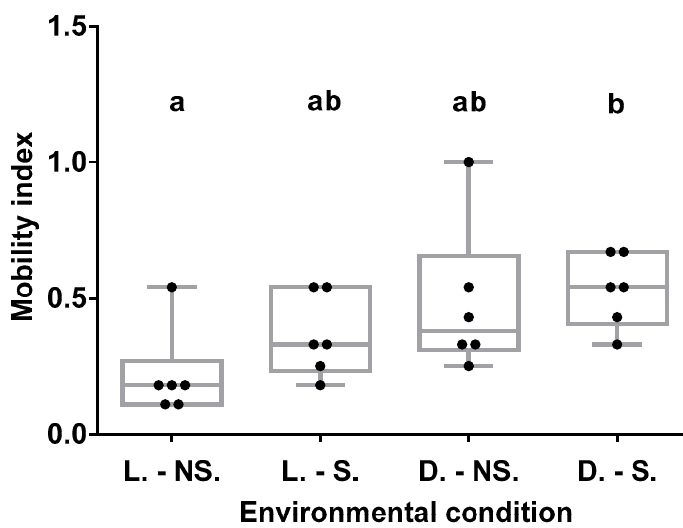
Figure 3. Darkness and starvation are the conditions that generate the most movement on C. sordidus (BW), they are the best environmental conditions for analyzing the mobility of BW in olfactometer assays. Abbreviations: L-NS = Light and no starvation, L-S = Light and starvation, D-NS = Darkness and no starvation and D-S = Darkness and starvation. Different letters indicate significant differences between treatments ( p < 0.05).